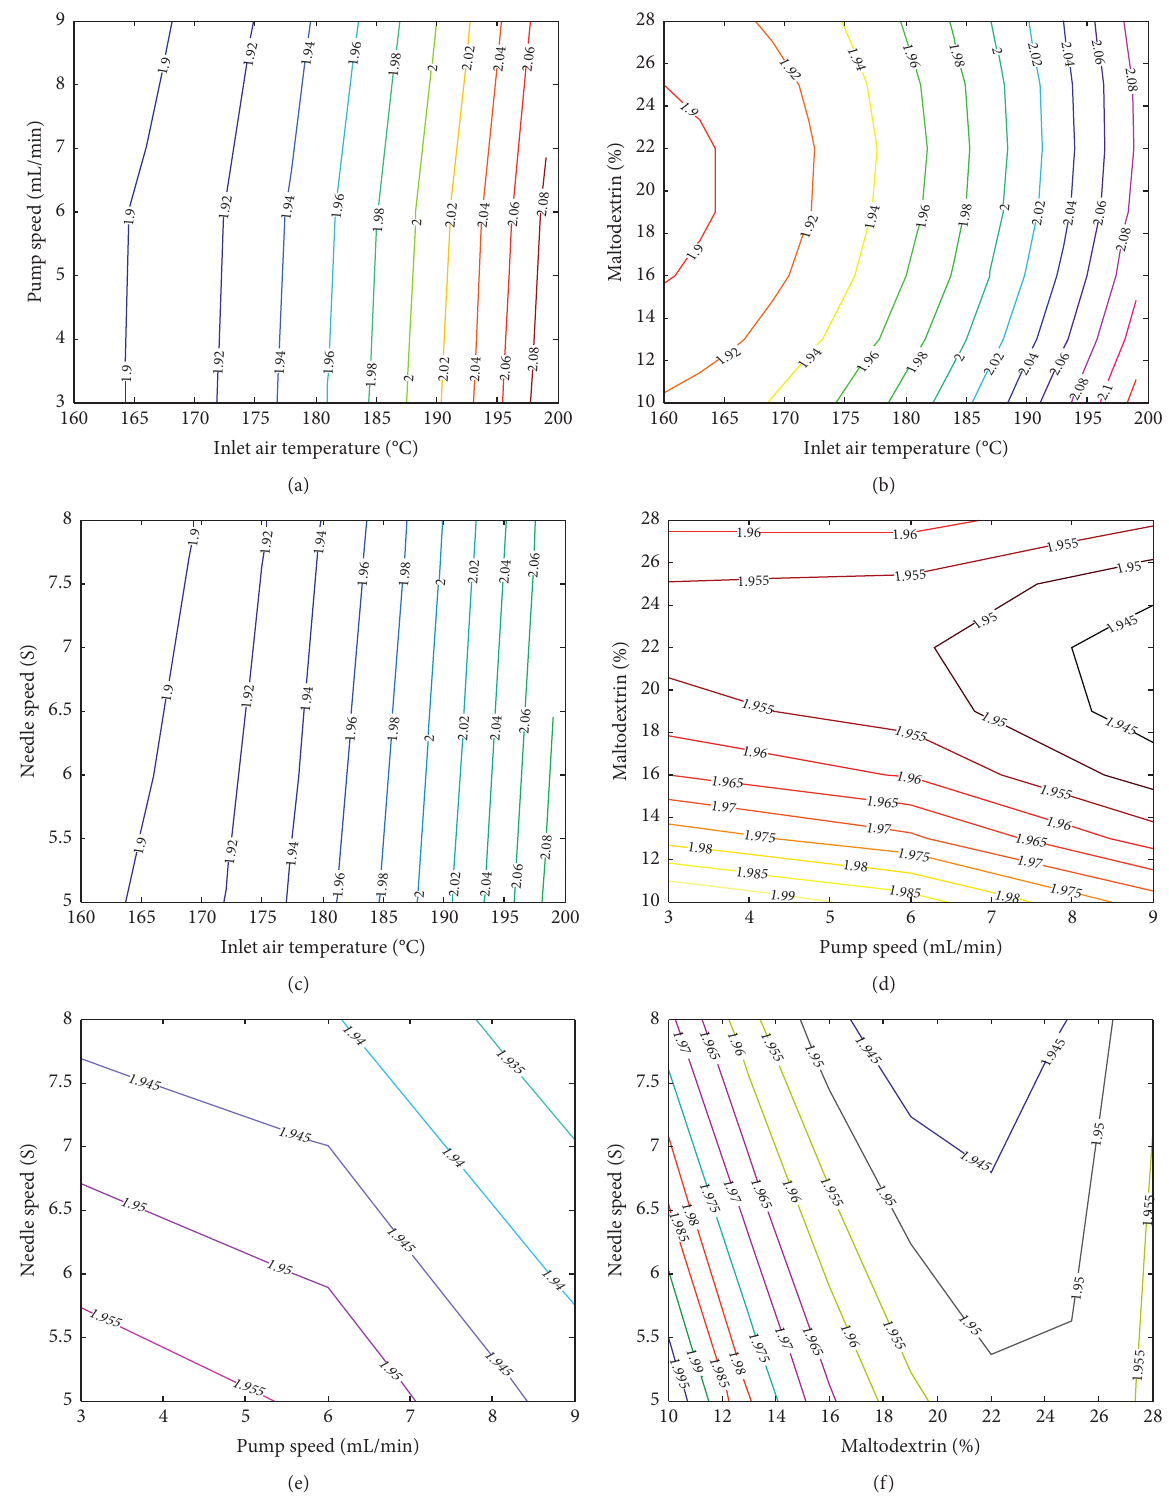
Figure 5: The mutual interaction impact of spray drying conditions on peroxide value of spray dried powder